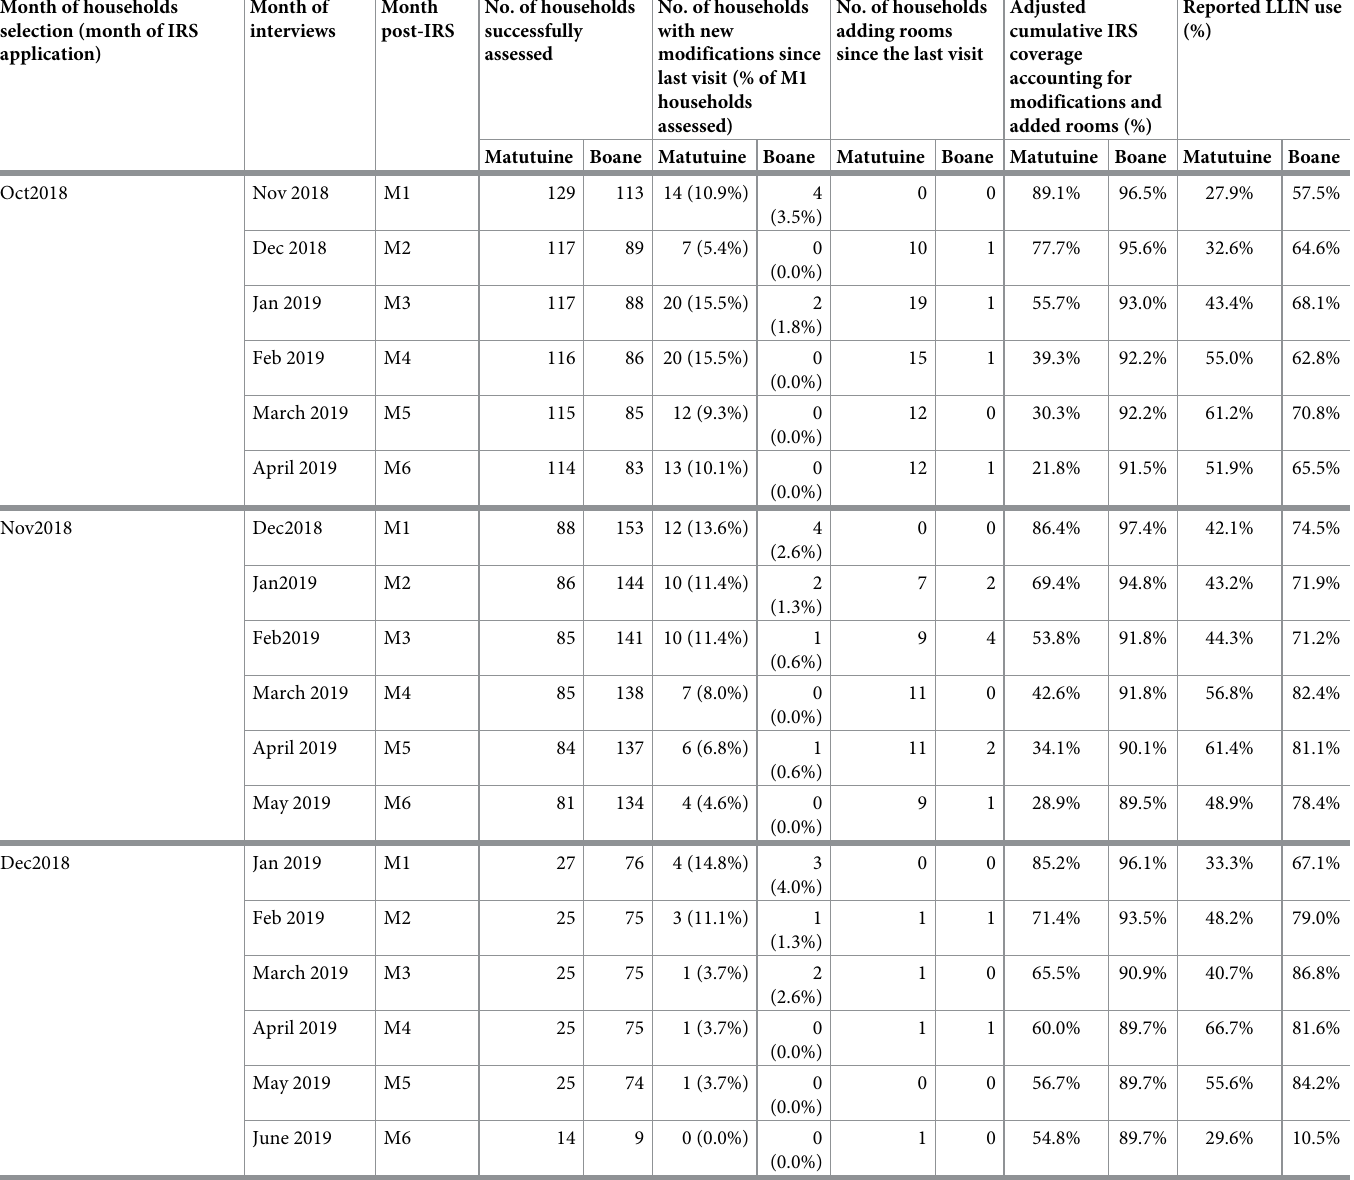
Table 1. Monthly household observations from Matutuine and Boane districts. The number of households visited for 6 months post-IRS to observe modifications to sprayed wall surfaces, or added rooms to the households, and the consequential adjusted IRS cover for communities receiving spray in October, November, or December 2018. Corresponding reported LLIN use is shown for each cohort. The total IRS coverage reported on the completion of the campaign was 96% in Matutuine and 97% in Boane, though this was accumulated across 4 months (mid-August 2018 to December 2018). Month of households selection (month of